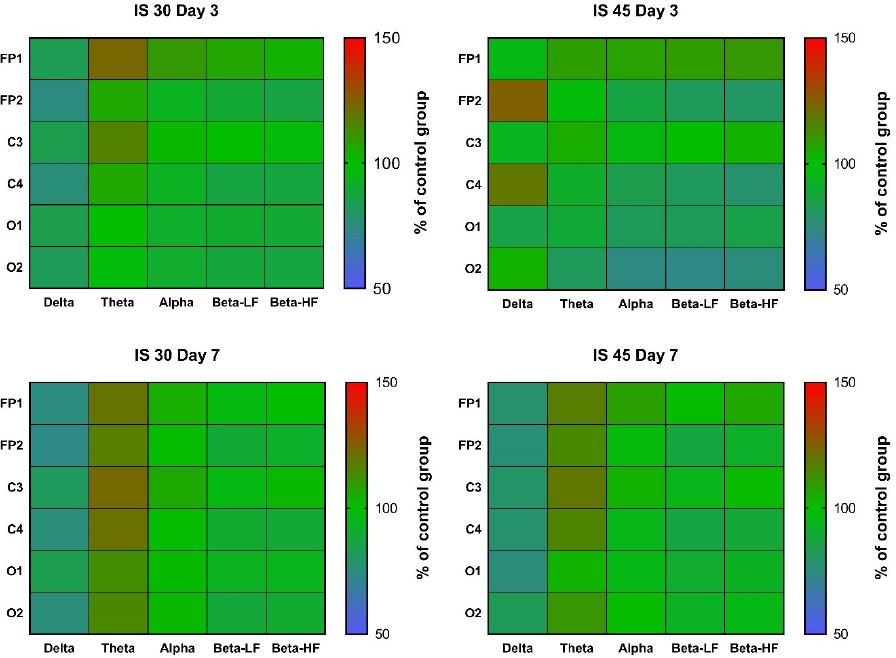
Figure 5. Heatmaps of mean amplitudes of δ , θ , α , high and low frequency β waves in channels FP1, FP2, C3, C4, O1, and O2 at post ‐ surgery days 3 and 7. Data were normalized to the respective control values ( n = 6). IS 30 ( n = 6) and IS 45 ( n = 6), groups subjected to cerebral ischemia for 30 and 45 min, respectively. Neurol. Int. 2022 , 14, FOR PEER REVIEW Spectral analysis did not reveal any distinct patterns of changes in any of the IS groups post ‐ surgery day 3 (Figure 6, Table S1). There was a slight decrease in α and β activity, which was more pronounced in IS 45 rats; however, due to the high data varia ‐ bility in all groups, no statistically significant differences were observed (Figure 6, Table S1). At day 7, the pattern of changes resembled that of the changes in rhythm indices and mean wave amplitudes; namely, a decrease in δ and an increase in θ activity were seen (not statistically significant) (Figure 6, Table S2).